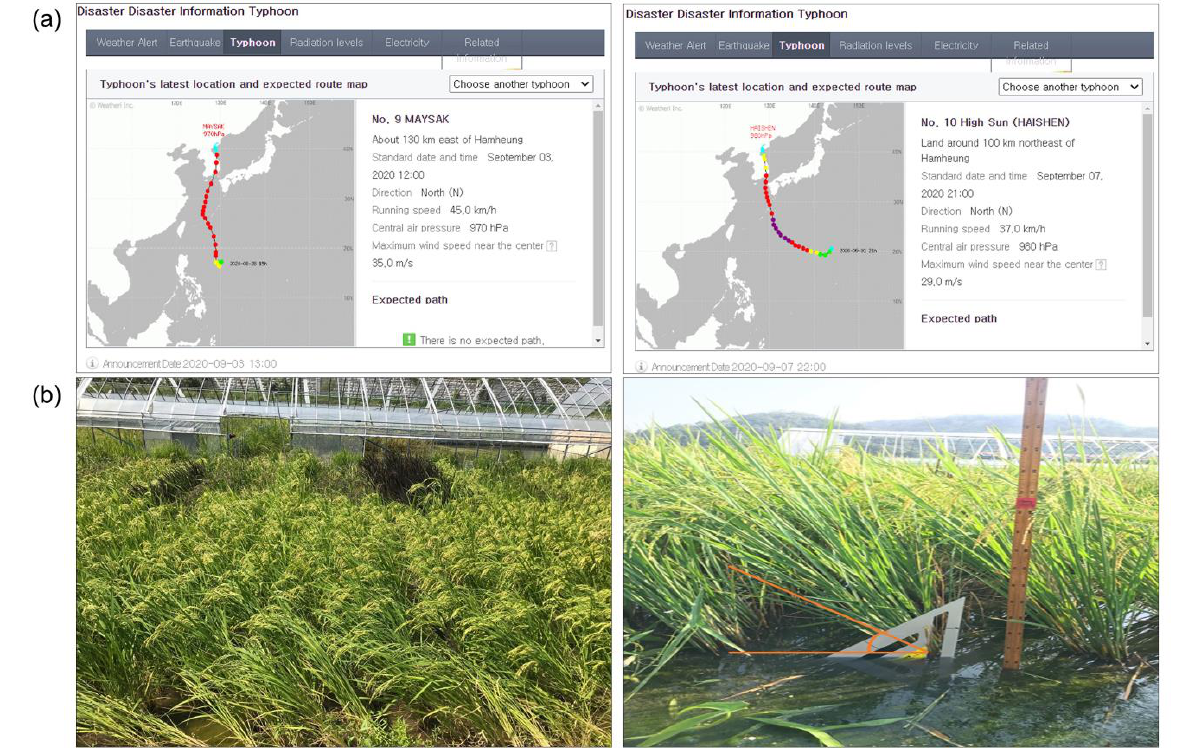
Figure 1. Information on typhoons Maysak and Haishen, and observation of plants during these periods. ( a ) Lodging resistance to typhoons was observed on 4 September 2020, the day after No. 9 Typhoon Maysak, and 8 September 2020, the day after No. 10 Typhoon Haishen. Typhoon Maysak had a running speed of 45 km/h, a central air pressure of 970 hPa, and a maximum wind speed near the centre of 35.0 m/s. Typhoon Haishen had a running speed of 37.0 km/h, a central air pressure of 980 hPa, and a maximum wind speed near the centre of 29.0 m/s. ( b ) Resistance rating was recorded on a scale of 0 (no prostrating) to 1 (little prostrating or prostrating).